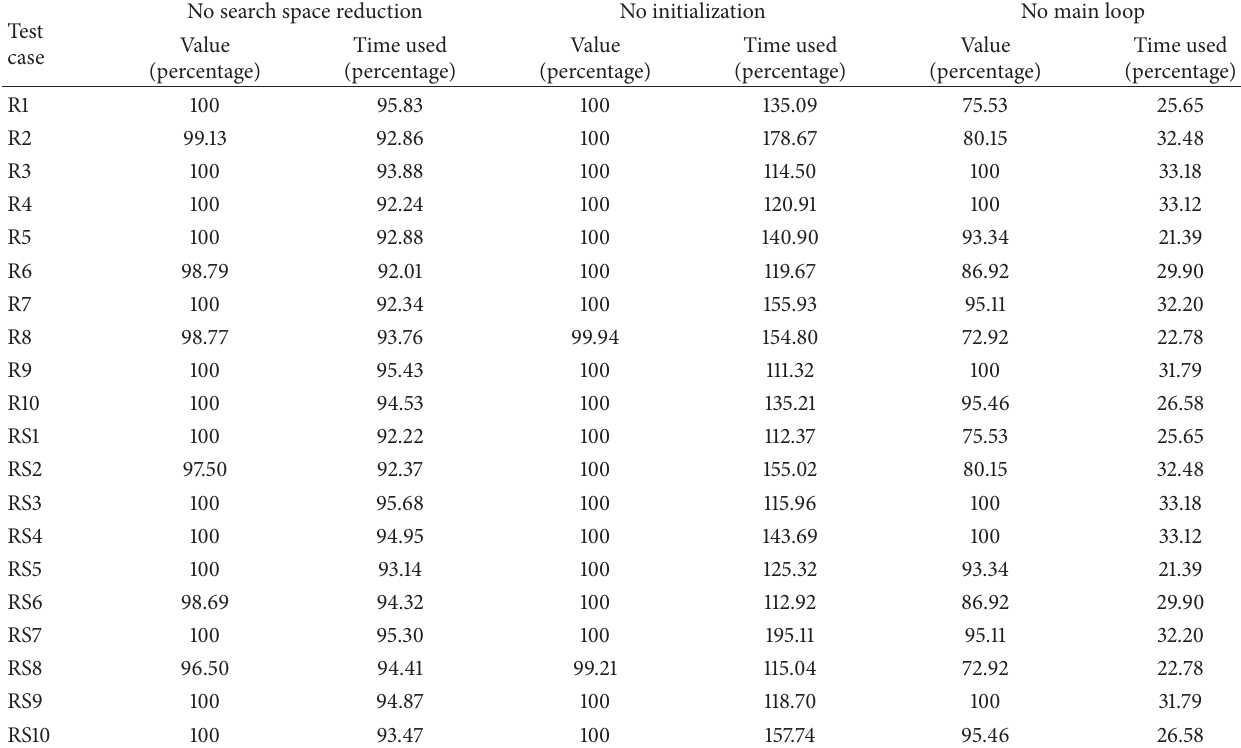
Table 7: Result of performance evaluation